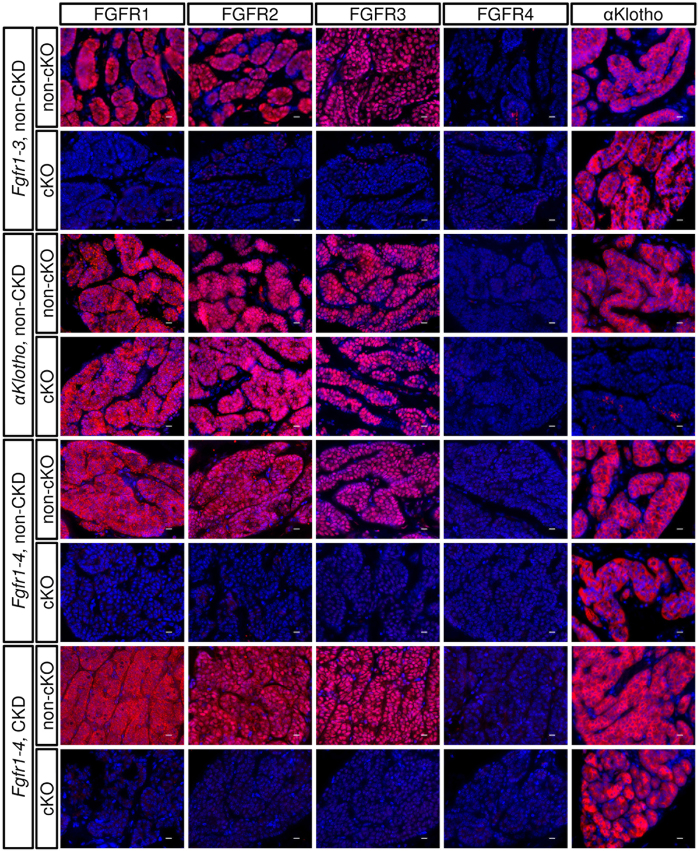
Expression of FGFRs (FGFR1, FGFR2, FGFR3, and FGFR4) and αKlotho in normal and genetically engineered parathyroid glands.A specific gene or genes were conditionally manipulated in the parathyroid glands by mating Fgfr1–3flox/flox, αKlothoflox/flox, or Fgfr1–4flox/flox mice with PTH-Cre mice (cKO) or without mating (non-cKO). The mice were treated with heminephrectomy plus a high-phosphate diet (CKD) or not treated (non-CKD) using the protocol described in the Methods section. Paraffin-embedded thyro-parathyroid glands were sectioned and immunostained (red) using an indirect immunofluorescence technique as described in the Methods section. Nuclei were stained with DAPI (blue). Scale bars: 10 μm.